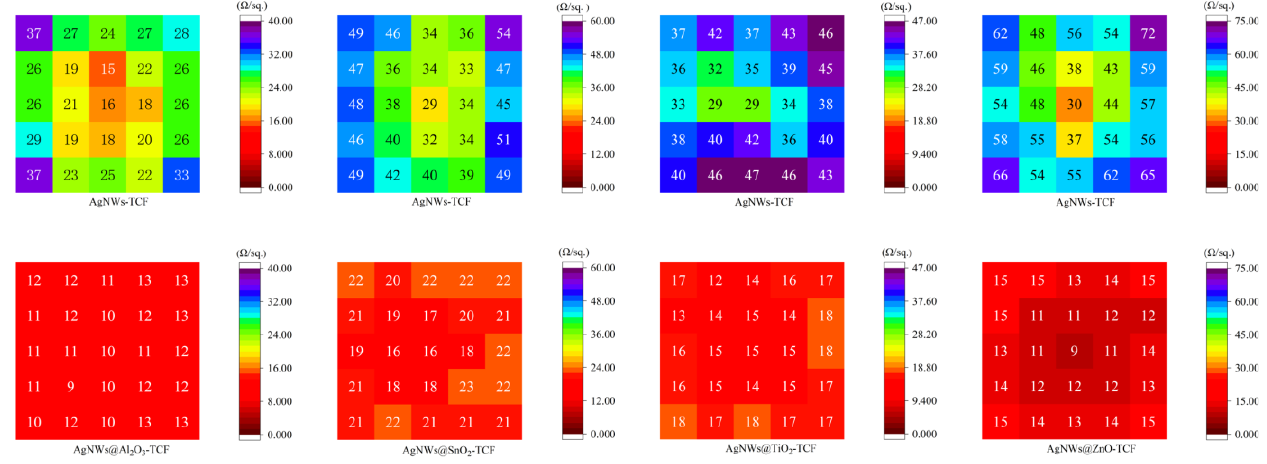
Figure 3. Mapping of samples #1~#4 before and after MONPs modification.